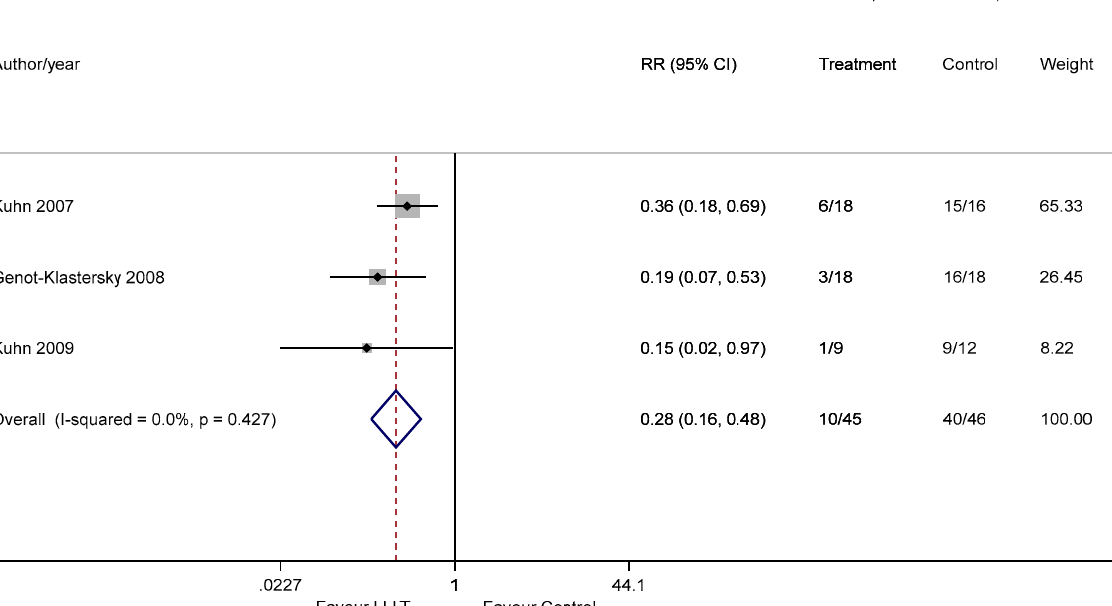
Figure 4. The sensitivity analysis forest plot illustrating the pooled estimate of PBM in reducing the severity of OM.